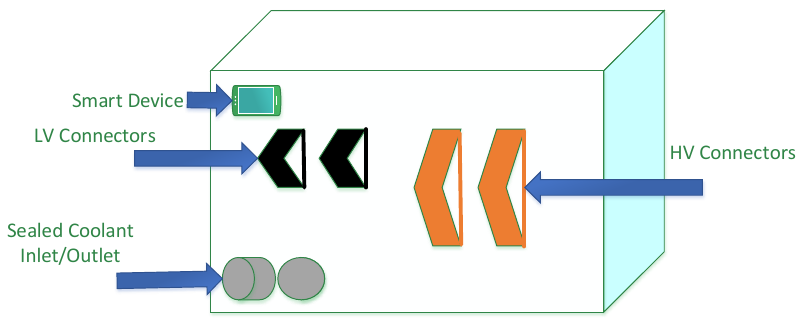
Figure 11. Universal battery pack (UBP) design.